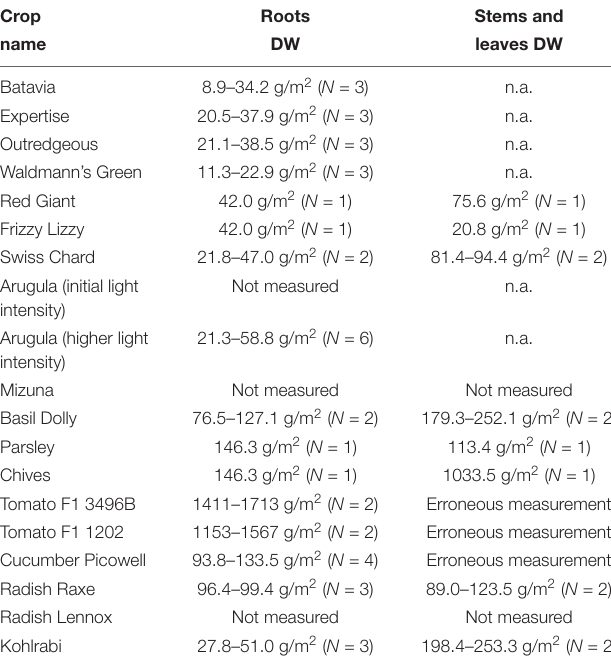
TABLE 4 | Dry weight (DW) ratio values for edible and inedible biomass. Edible Inedible